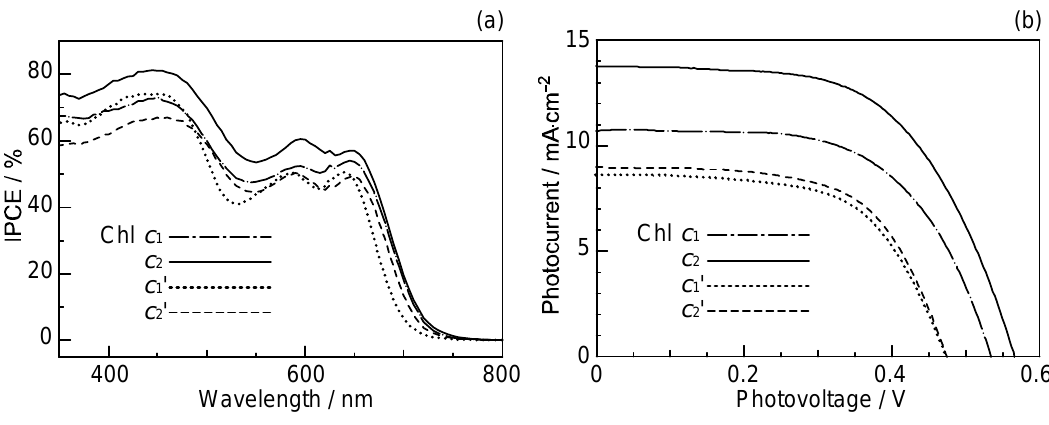
Figure 41. (a) The IPCE profiles and (b) the I – V curves of solar cells using the , Chl c , Chl c ′ and Chl c ′ sensitizers (reprinted from [21], Copyright (2007), with Chl c 1 2 1 2 permission from Elsevier).